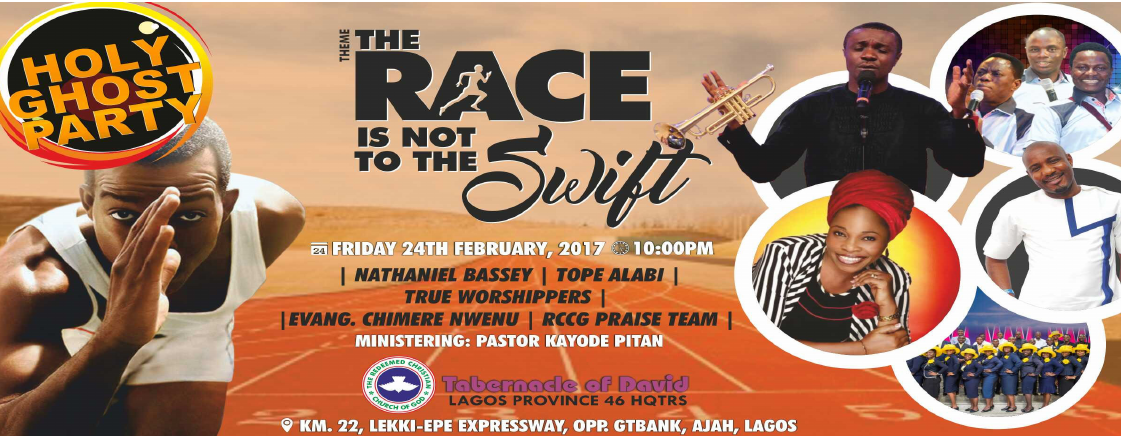
Figure 2 . This is a poster for a religious/Christian event at a parish of The Redeemed Christian Church of God (RCCG), one of Nigeria’s most popular Pentecostal churches. The poster is composed of graphic design that alludes to the theme of the event and the event’s promotion pictures of Tope Alabi, Nathaniel Bassey (another Nigerian popular gospel musician), a group photograph of the church choir and four other gospel singers who are members of RCCG’s national praise team. (Im ‐ age: courtesy of RCCG Tabernacle of David Parish, Ajah, Lagos, accessed on 15 January 2022).